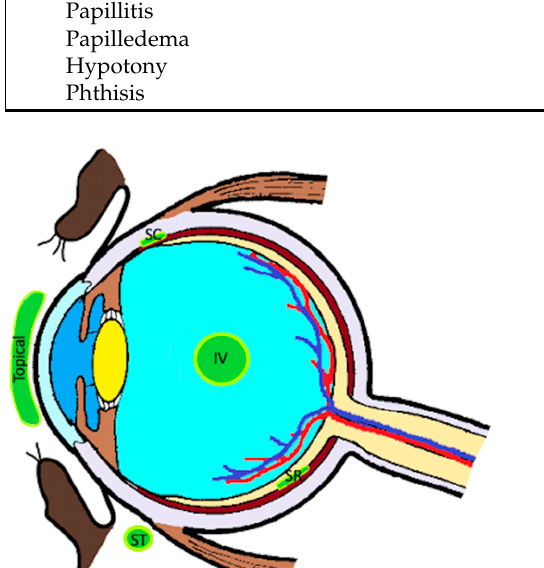
Figure 1. Routes of local drug delivery. IV, intravitreal; SC, suprachoroidal; SR, subretinal; ST, sub- tenon’s.